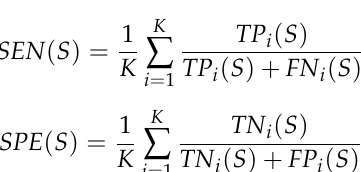
( b ) Normalized data